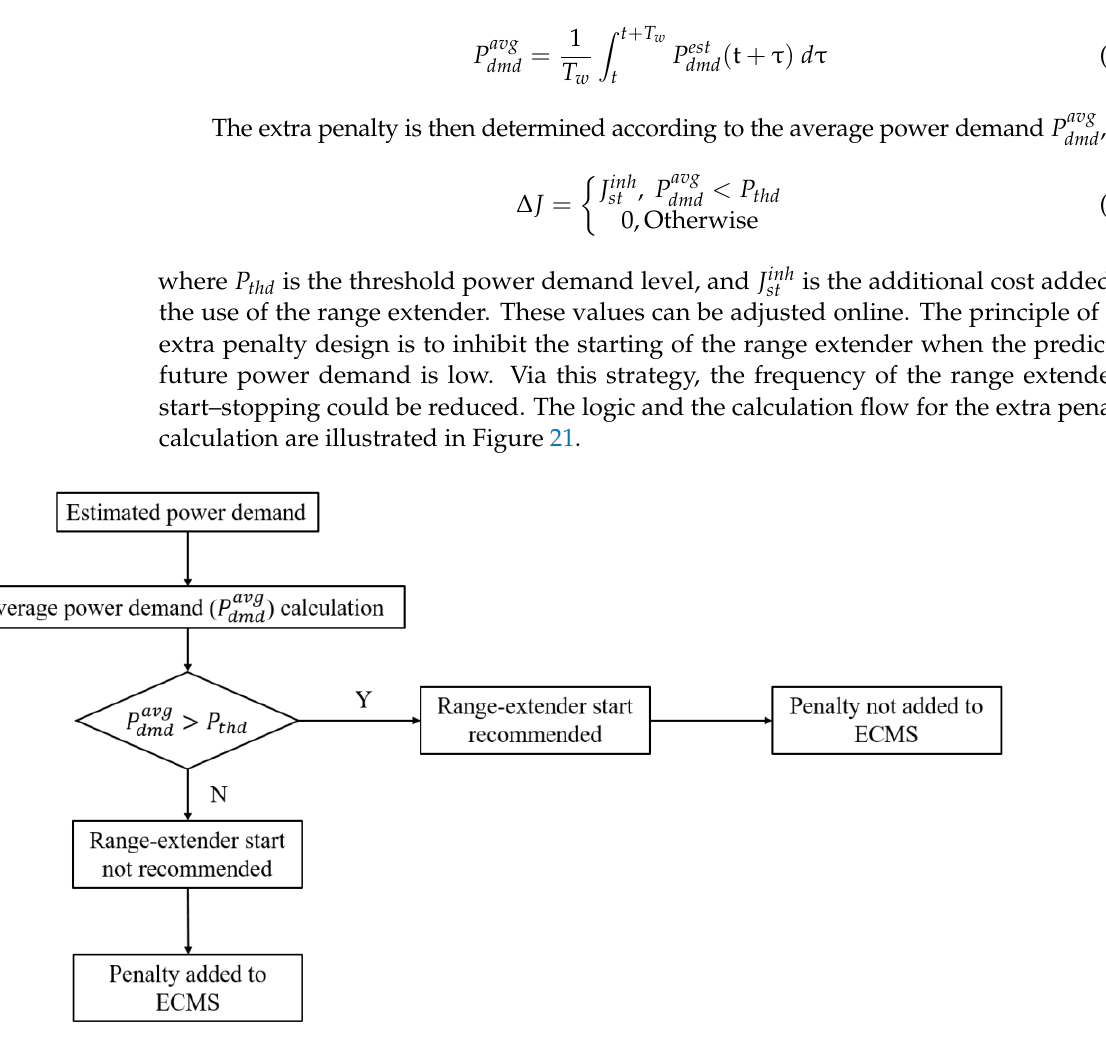
Figure 21. Logical diagram of the penalty